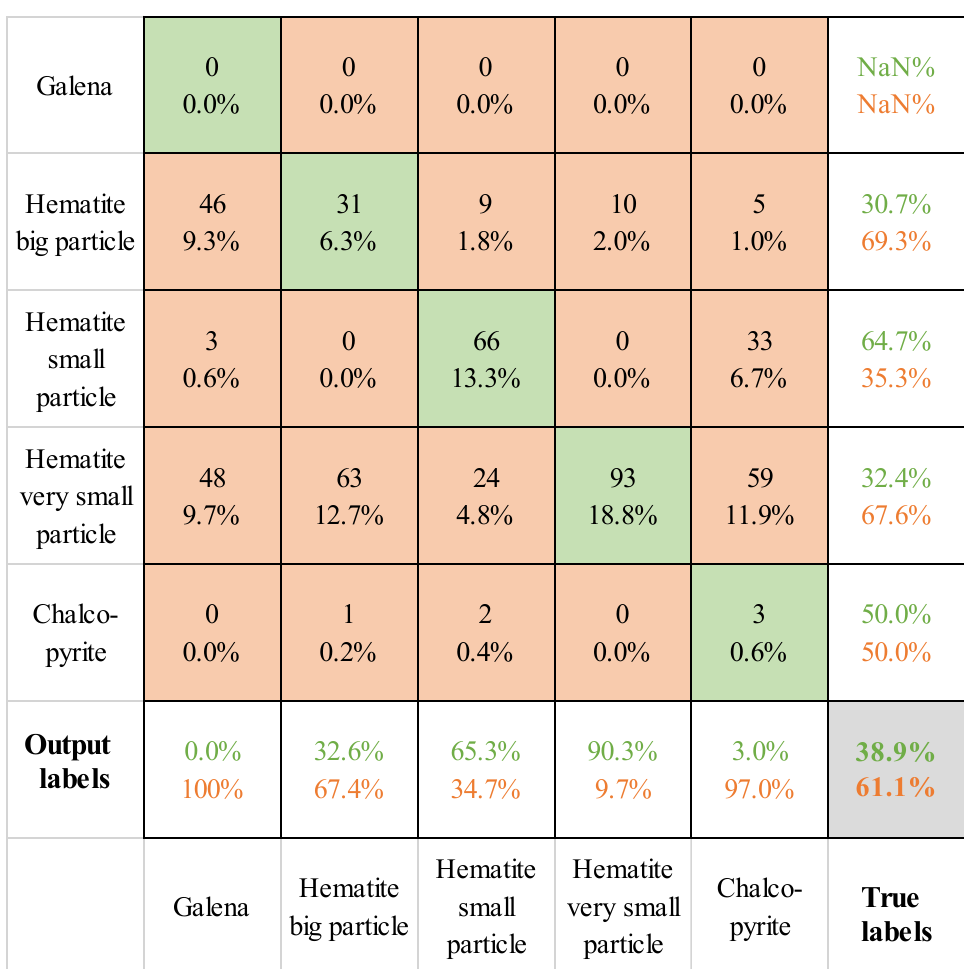
Figure 11. Confusion matrix for the RGB image deep learning results for the test data.